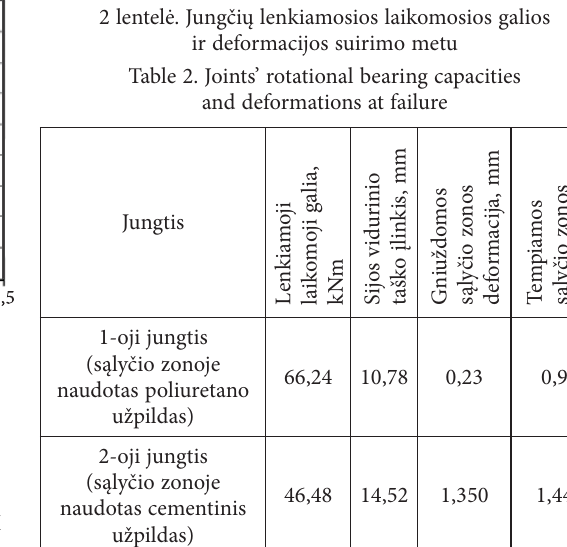
Fig. 10. Load – displacement curve of J-1-PUR and J-2-CEM beams’ tension